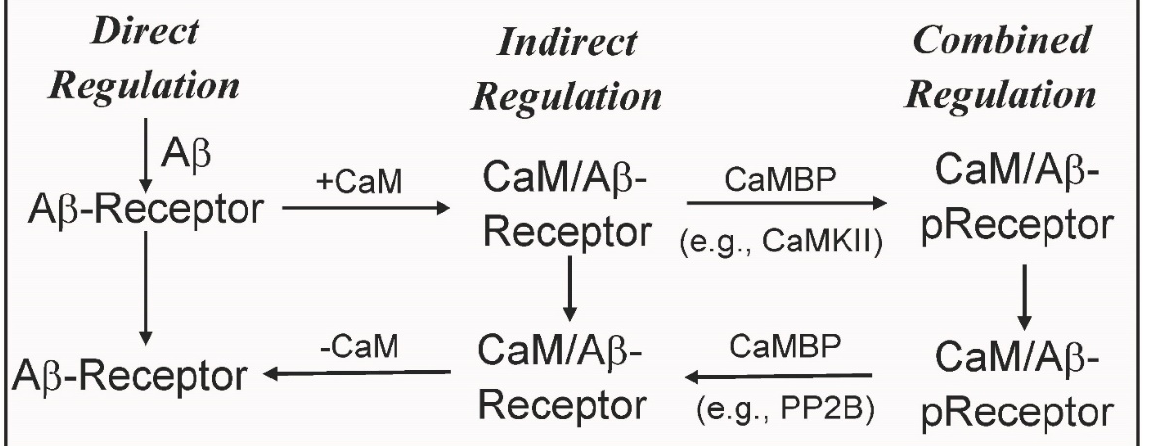
Figure 3. Some types of regulation open to A β receptors that are calmodulin binding proteins. pReceptor = phosphorylated receptor. See text for details.